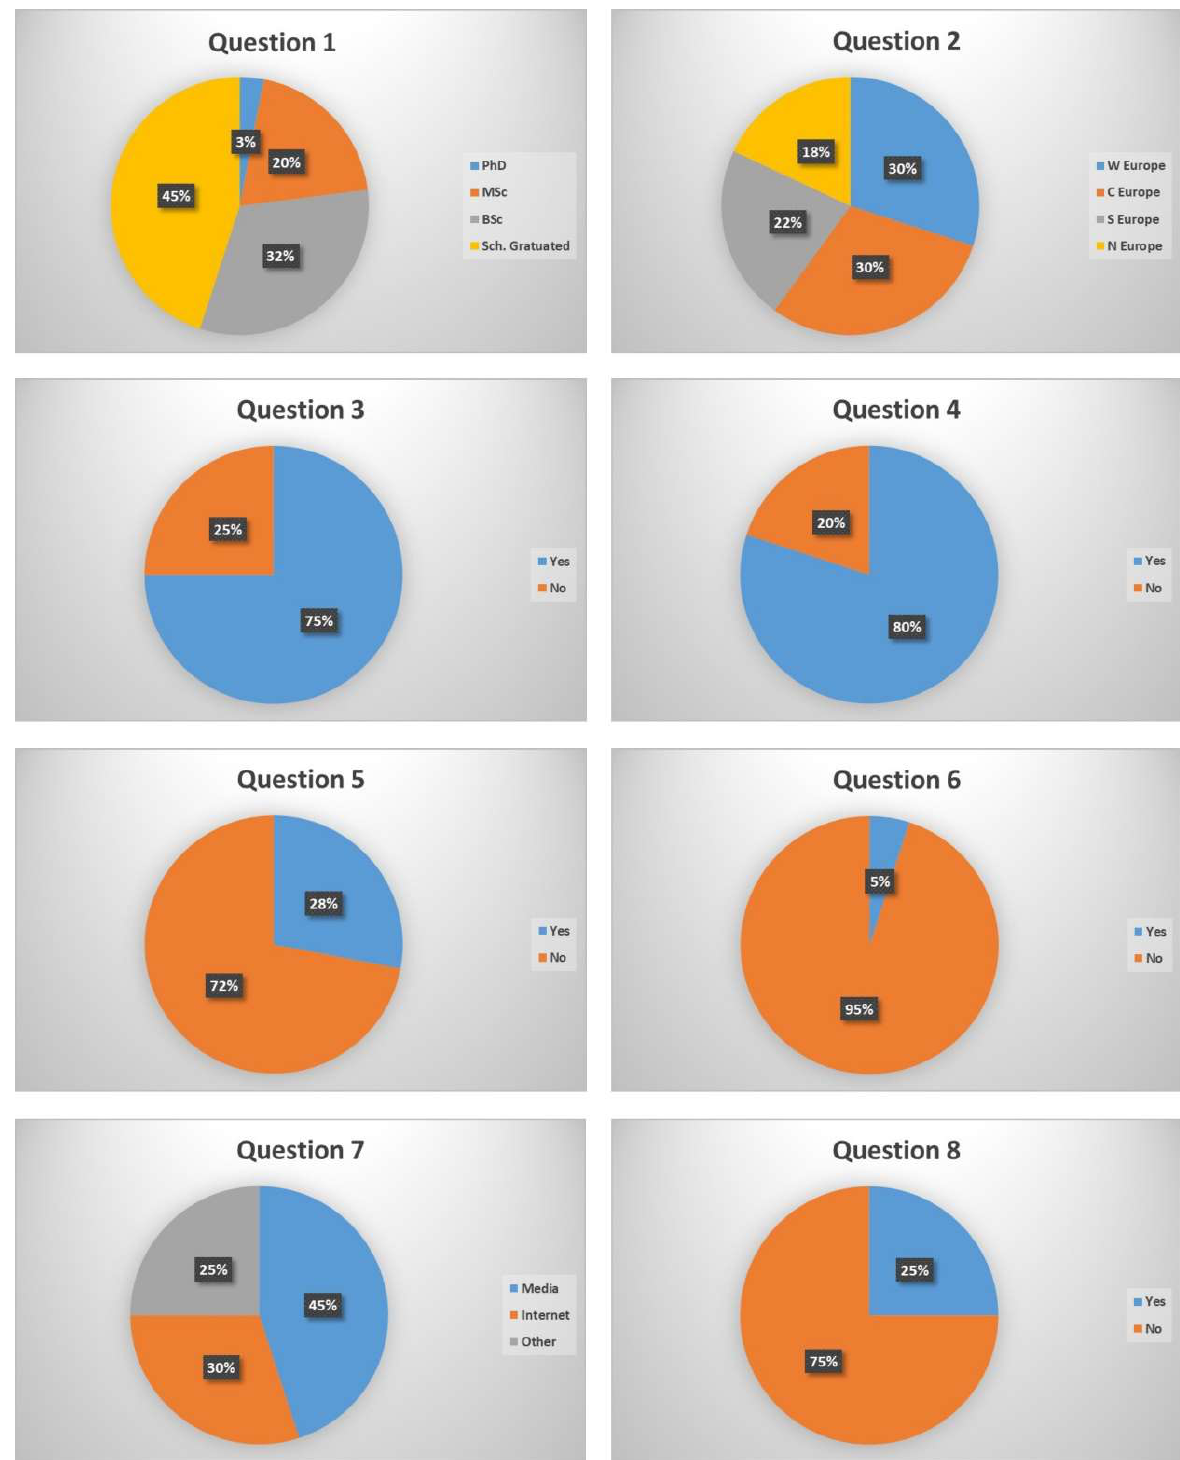
Figure 6. Excel pie charts showing the answers from the questionnaires (answers to questions 1 to 8).